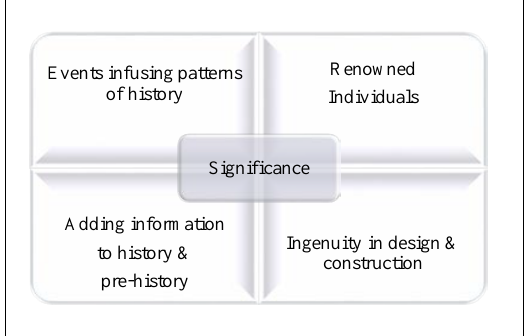
Figure 2. NRHP significance criteria that drive information acquisition and reduction